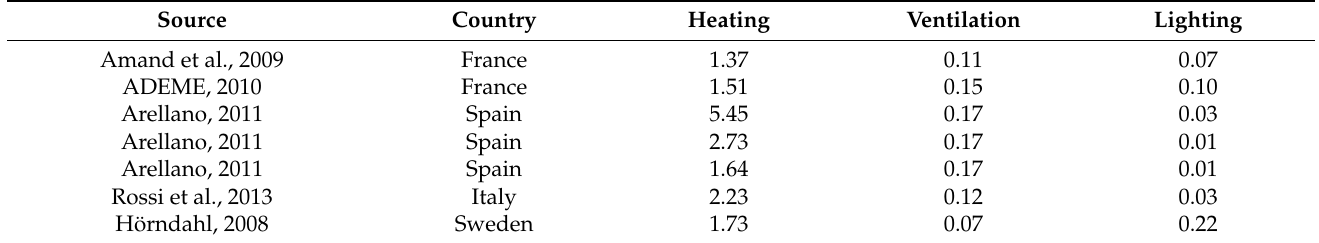
Table 4. Heating, ventilation, and lighting energy consumption in broiler systems MJ/kg meat (based on